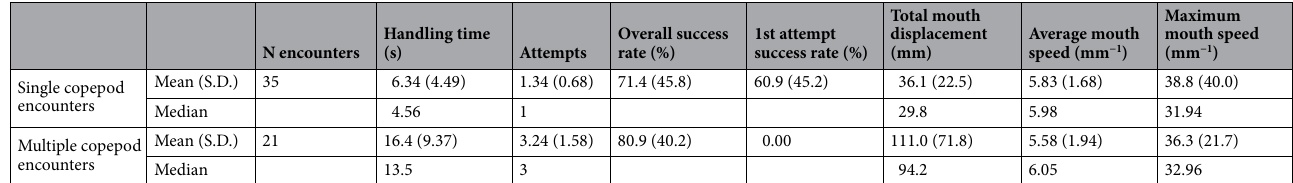
Table 1. Mean (S.D.) and median values for parameters measured in both single and multiple copepod encounters.